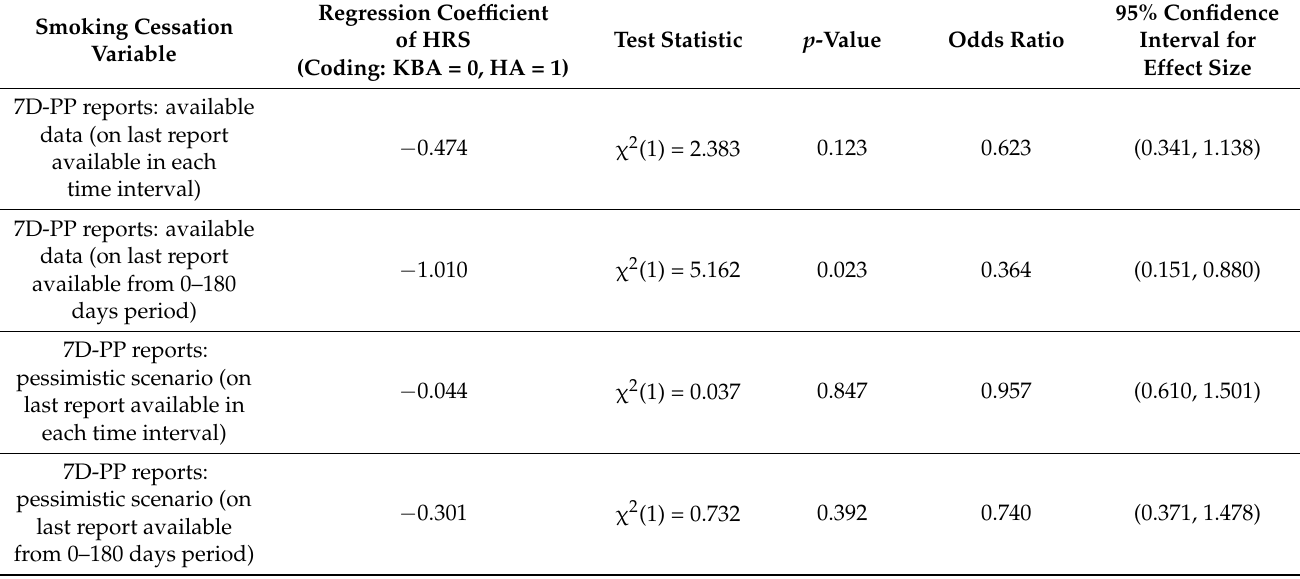
Table 5. Comparison between the two HRS groups of their results for main effects on smoking cessation variables for non-dropouts over the time period of 0–180